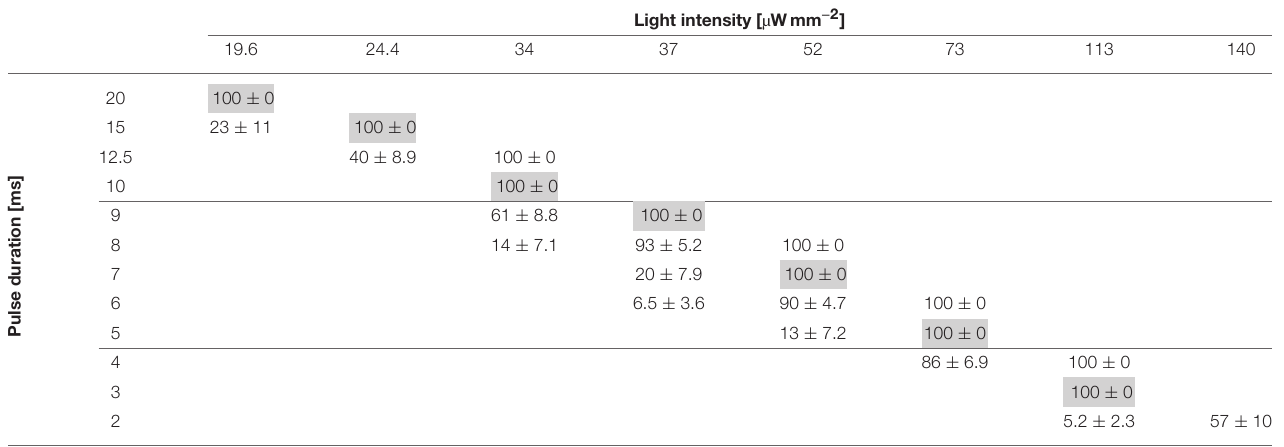
TABLE 1 | Measured pulse duration and light intensity